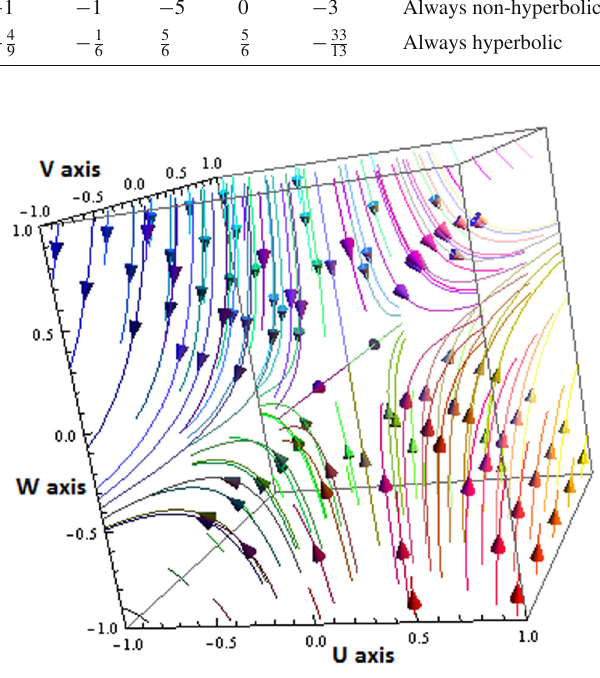
Fig. 14 3 Dimensional phase plot for the critical point P 10 1) when the parameter μ passes through zero. Similar phe- nomenon can be found on the V W -plane. Despite each of P 8 and P 9 changes its stability at μ = 0, they together produce topological equivalent phase space for all μ . Since the phase space in confined in a finite region of space, there is a tra- jectory of non-generic evolution between P 8 and P 9 on UV or V W -plane. As there is no μ in the eigenvalues of (86), so qualitative behavior near P 10 does not depend on μ . The Poincaré index of P 10 restricted on u v -eigenplane is 1 and each on the two other plans is − 1 and is independent of the sign of μ . But in cosmological point of view, near the critical point P 10 , for μ > 0, the comoving field behaves as a phan- tom field with runaway potential, whereas the field behaves as non-phantom with non-runaway potential when crosses the phantom barrier at μ = 0 from positive to